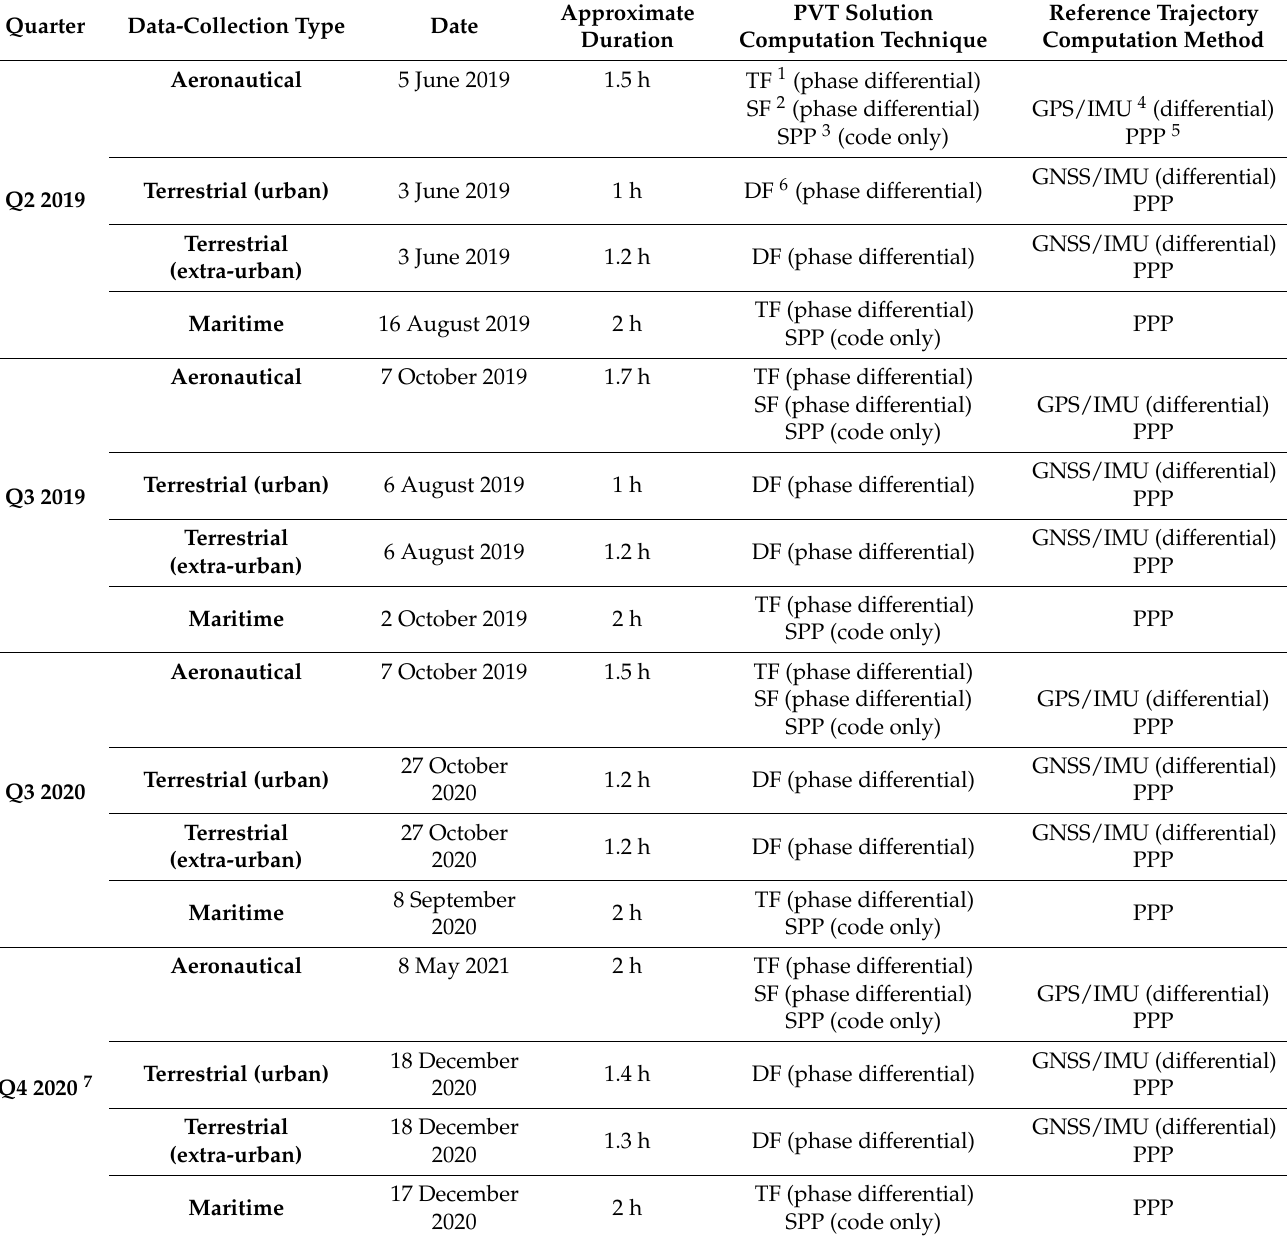
Table 4. Data-collection